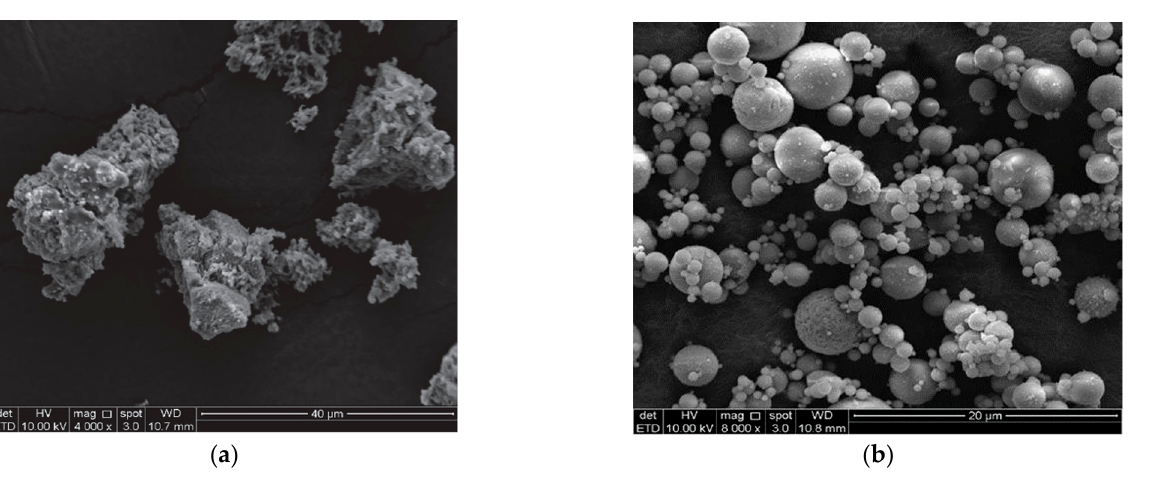
Figure 2. FESEM images of ( a ) wood ash and ( b ) fly ash (reprinted from Abdulkareem et al. [38], with permission of AIP Publishing).